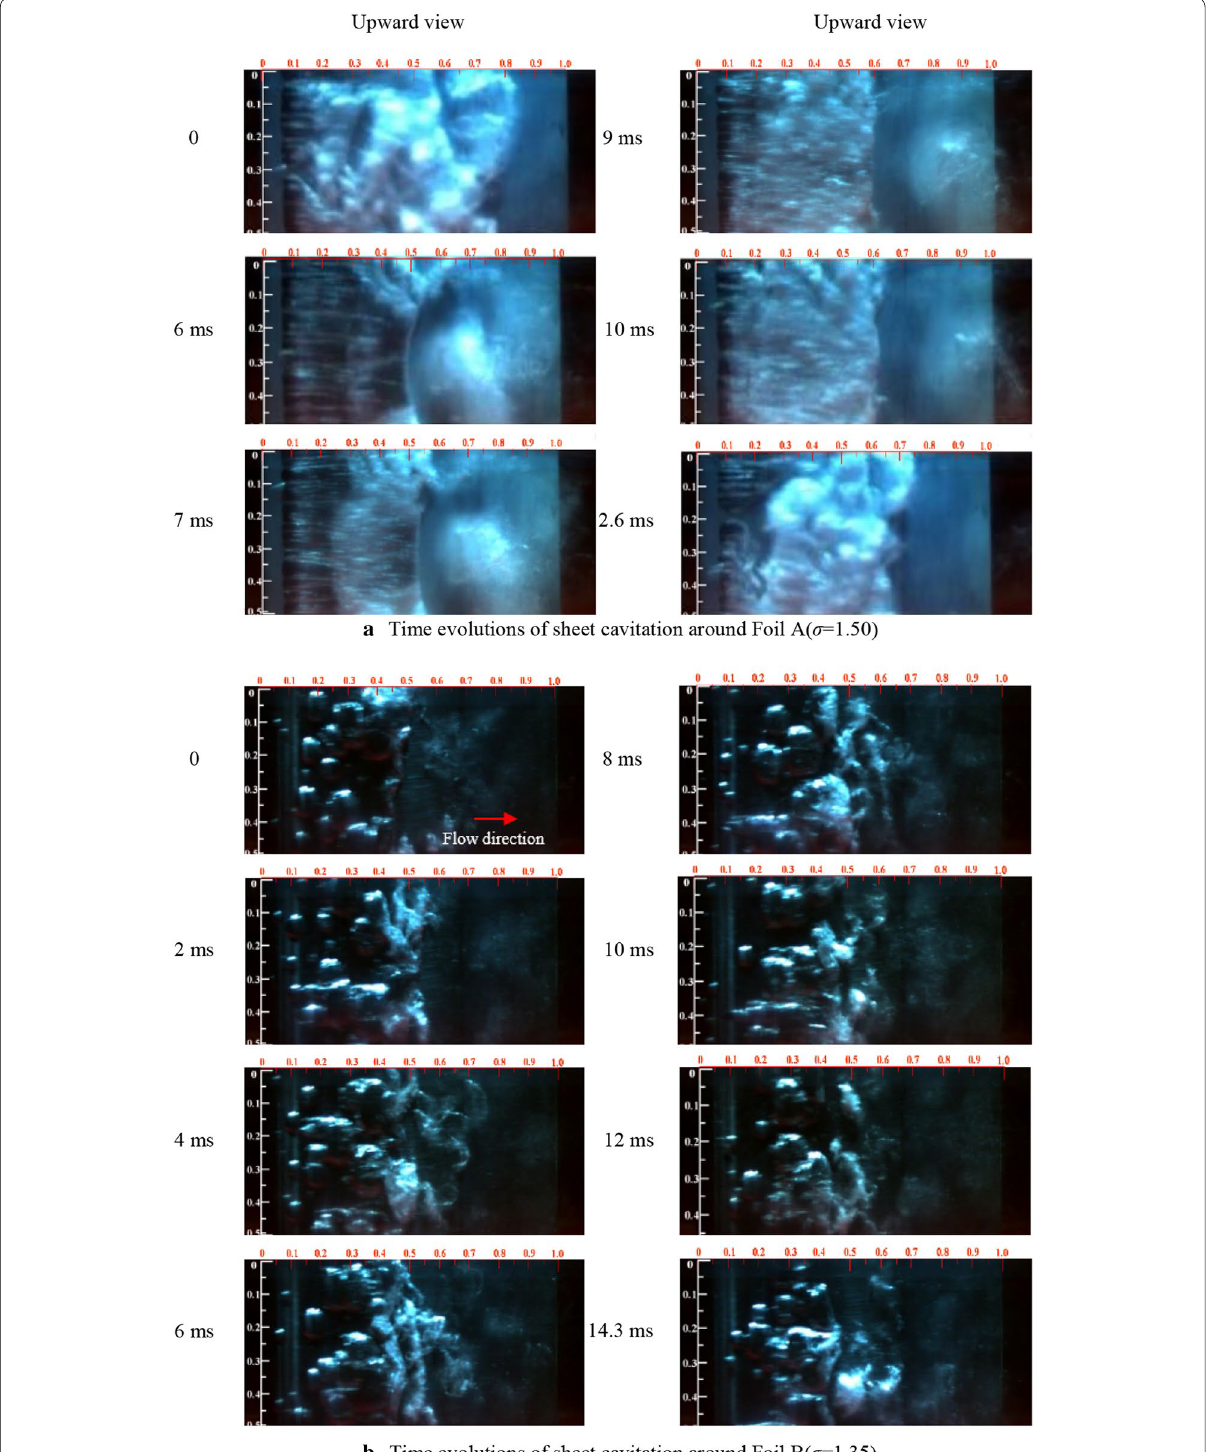
Figure 5 Time evolutions of sheet